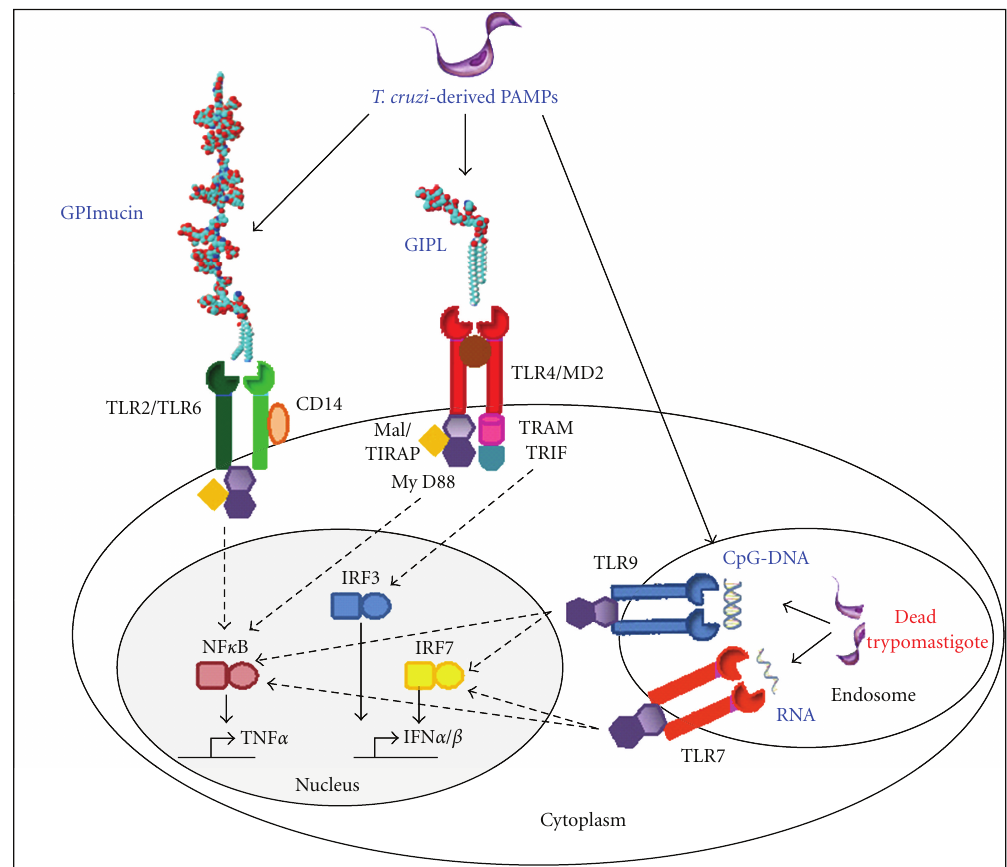
Figure 1: T. cruzi -derived PAMPs are recognized by di ff erent TLRs. The recognition of di ff erent T. cruzi molecules, like parasite surface glycoconjugates and nucleic acids, occurs through distinct Toll-like receptors, which are localized at the cellular plasma or endoplasmic membranes, respectively, and are di ff erentially expressed by various innate immune cell types. GPI anchors of mucin-like glycoproteins activate TLR2/TLR6 heterodimer, GIPL is an agonist for TLR4, genomic DNA activates endosomal TLR9, and TLR7 is involved in parasite RNA recognition. TLRs induce NF- κ B and/or IRFs activation via their interaction with di ff erent TIR domain-containing adaptor molecules. Of these, MyD88 and Mal/TIRAP are required for TLR2 and TLR4 activation of NF- κ B. In a MyD88-independent way, TRIF and TRAM signal downstream TLR4, activating IRF3. TLR7 and TLR9 activate NF- κ B and IRF7 via MyD88. NF- κ B activation leads to proinflammatory cytokines production, such as TNF- α and IL-12, whereas IRFs are required for type I IFN gene